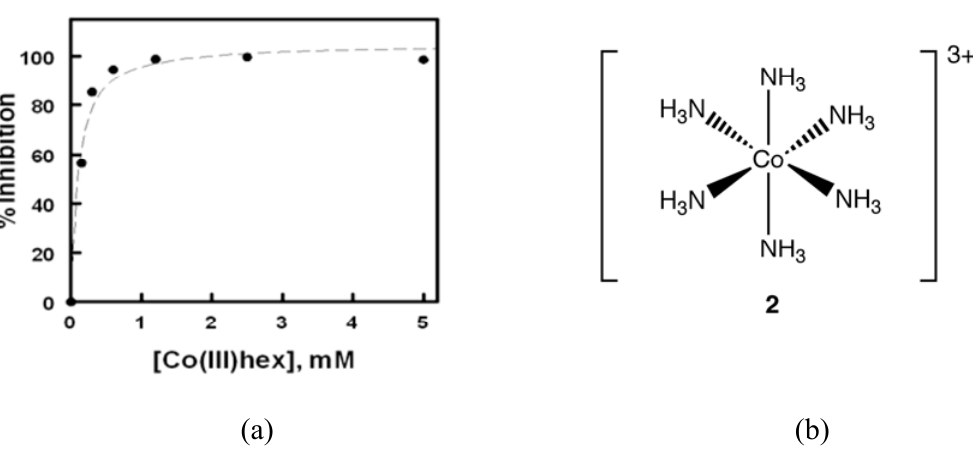
Figure 3. (a) Degree of inhibition of Sindbis virus plaque formation plotted as a function for inhibition was determined to be of Cohex concentration for the 48 h data set. The IC 50 0.10 ± 0.04 mM Cohex using a one-site dose response logistic curve fit function. (b) Structure of Cohex cation 2 (chloride counterions omitted for